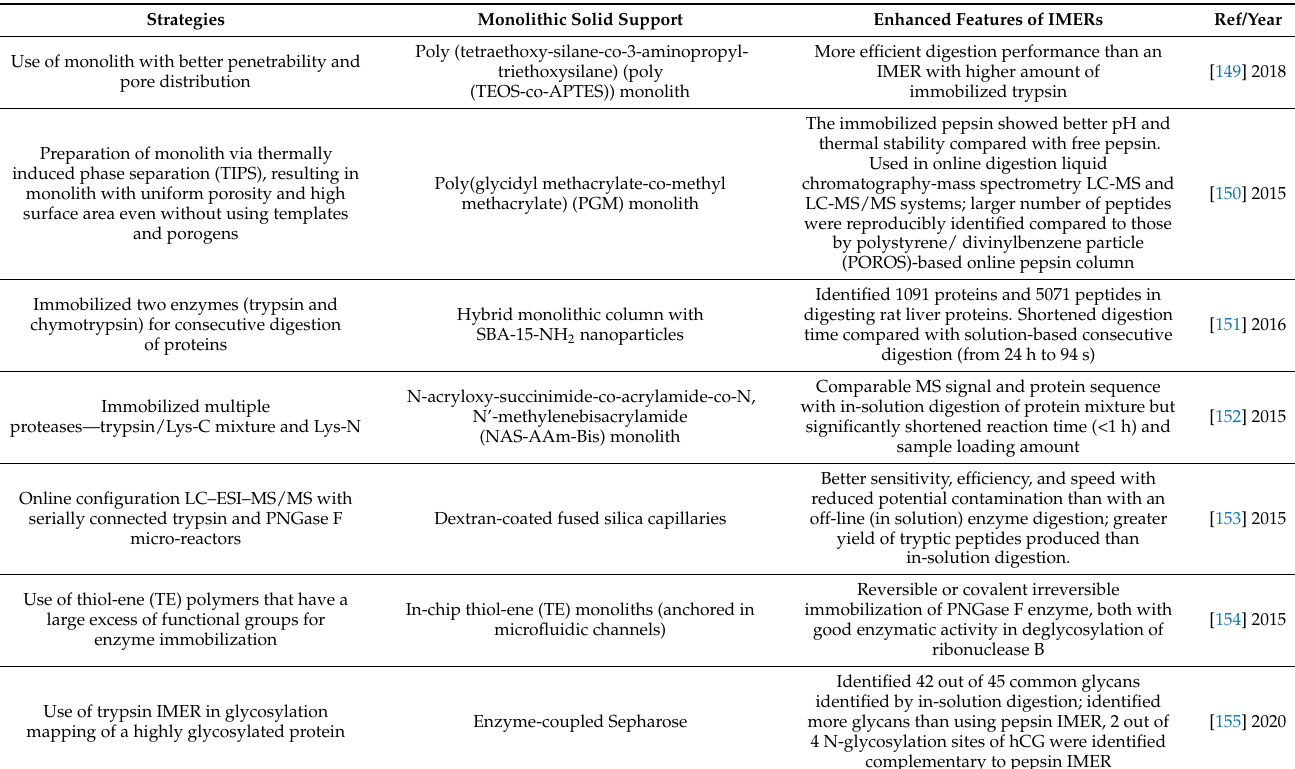
Table 3. Recent strategies in development of IMERs for in glycoprotein